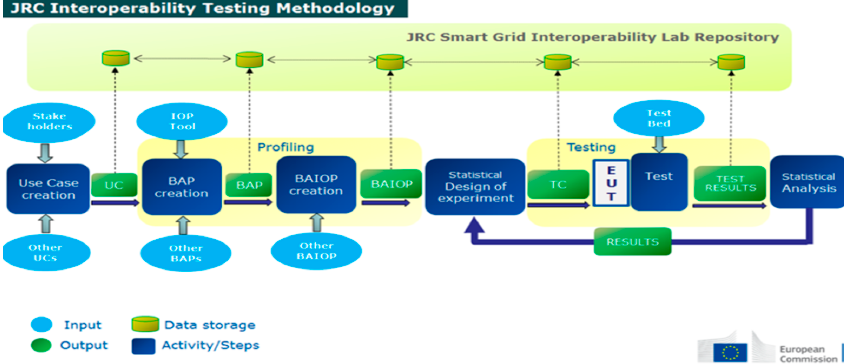
Figure 2. Joint Research Centre (JRC) proposed methodology flowchart [17].